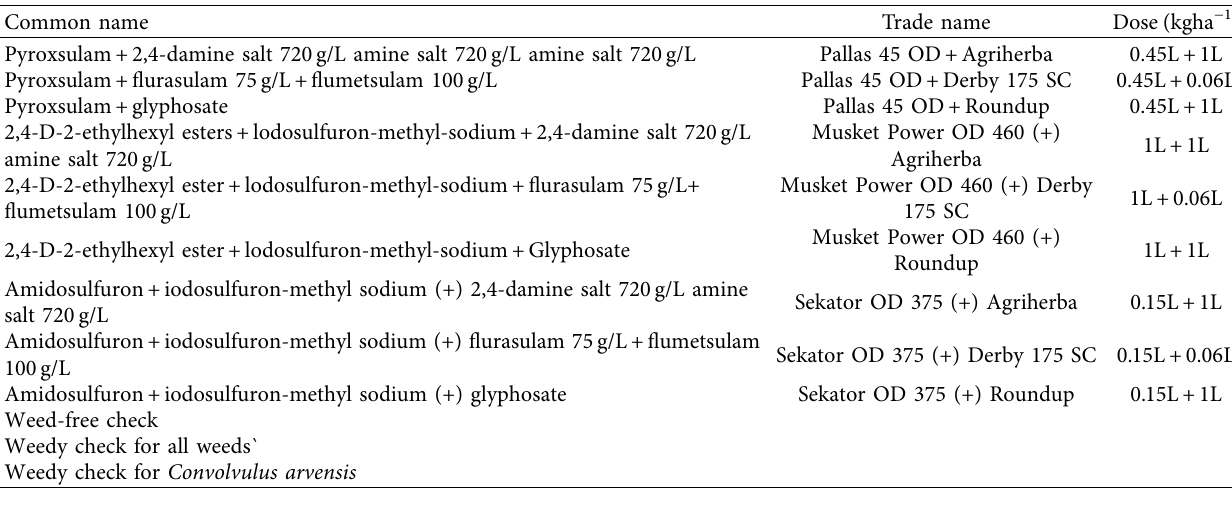
Figure 1: Monthly two- and forty-nine-year average precipitation (bar) and maximum and minimum air temperature(line) at the ex- perimental site from November 1972 to December 2021. Table 1: Description of